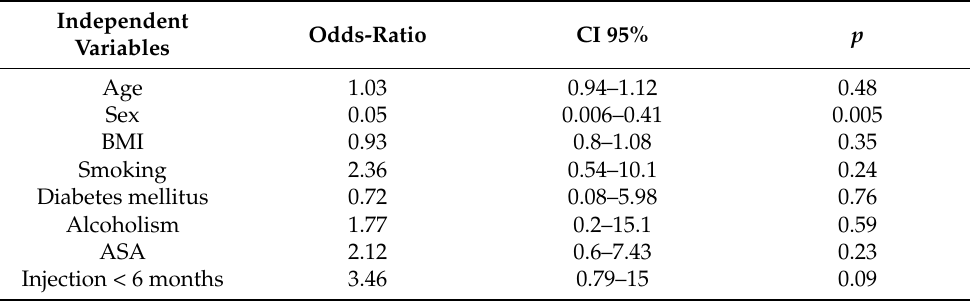
Table 3. Univariate logistic regression according to patients’ characteristics. Independent